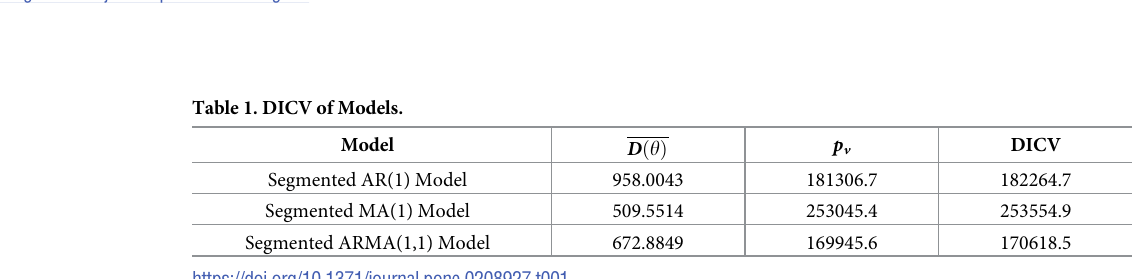
Fig 12. Estimated change-point locations with posterior probability greater than 0.5 for AR(1), MA(1) and ARMA(1,1) model.